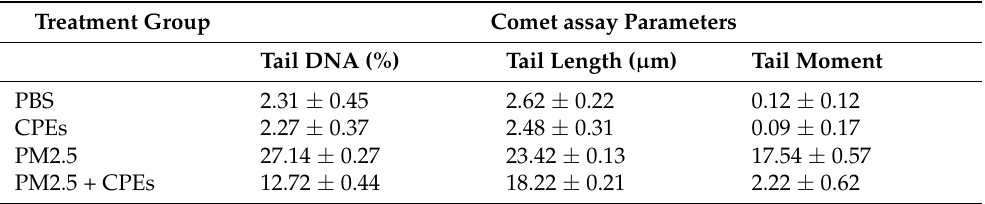
Table 2. The parameters of DNA damage in alkaline comet assays of fibrolasts with PM2.5 or plus CPEs treatment for 24 h. PBS-treatment was used as the negative